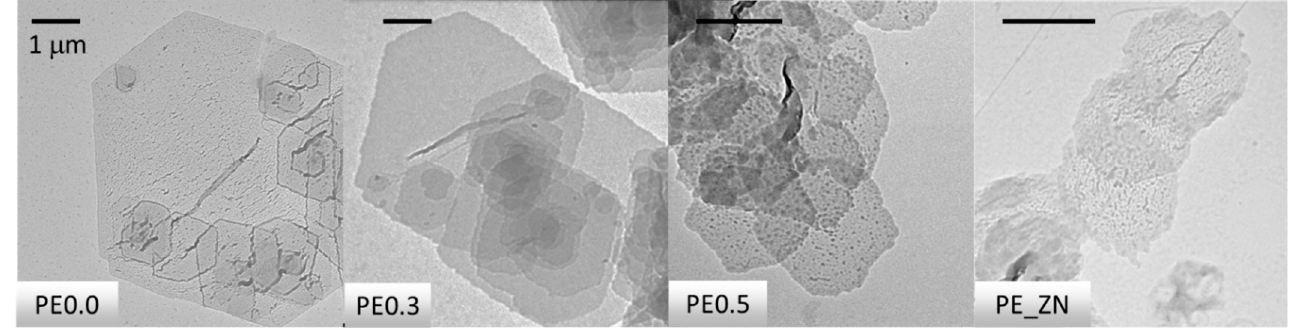
Figure 1. TEM images of the single crystals in PE00, PE0.3, PE0.5 and PE_ZN samples. The bars correspond to a size scale of 1 μ m in all cases.